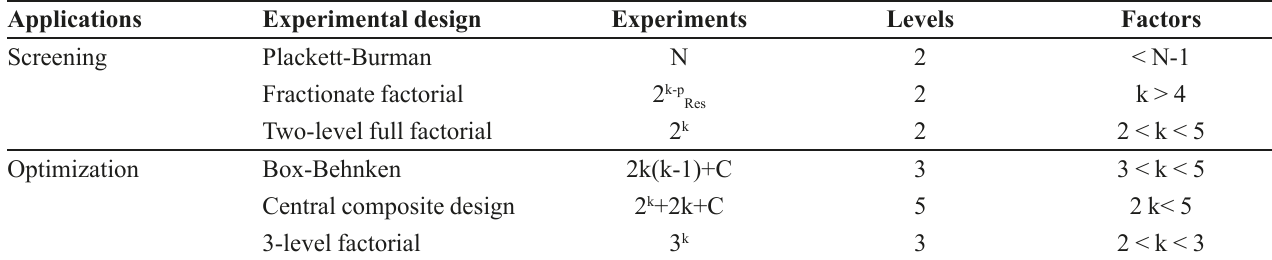
TABLE I – Summary of screening and optimization designs characteristics, number of experiments, levels, and factors